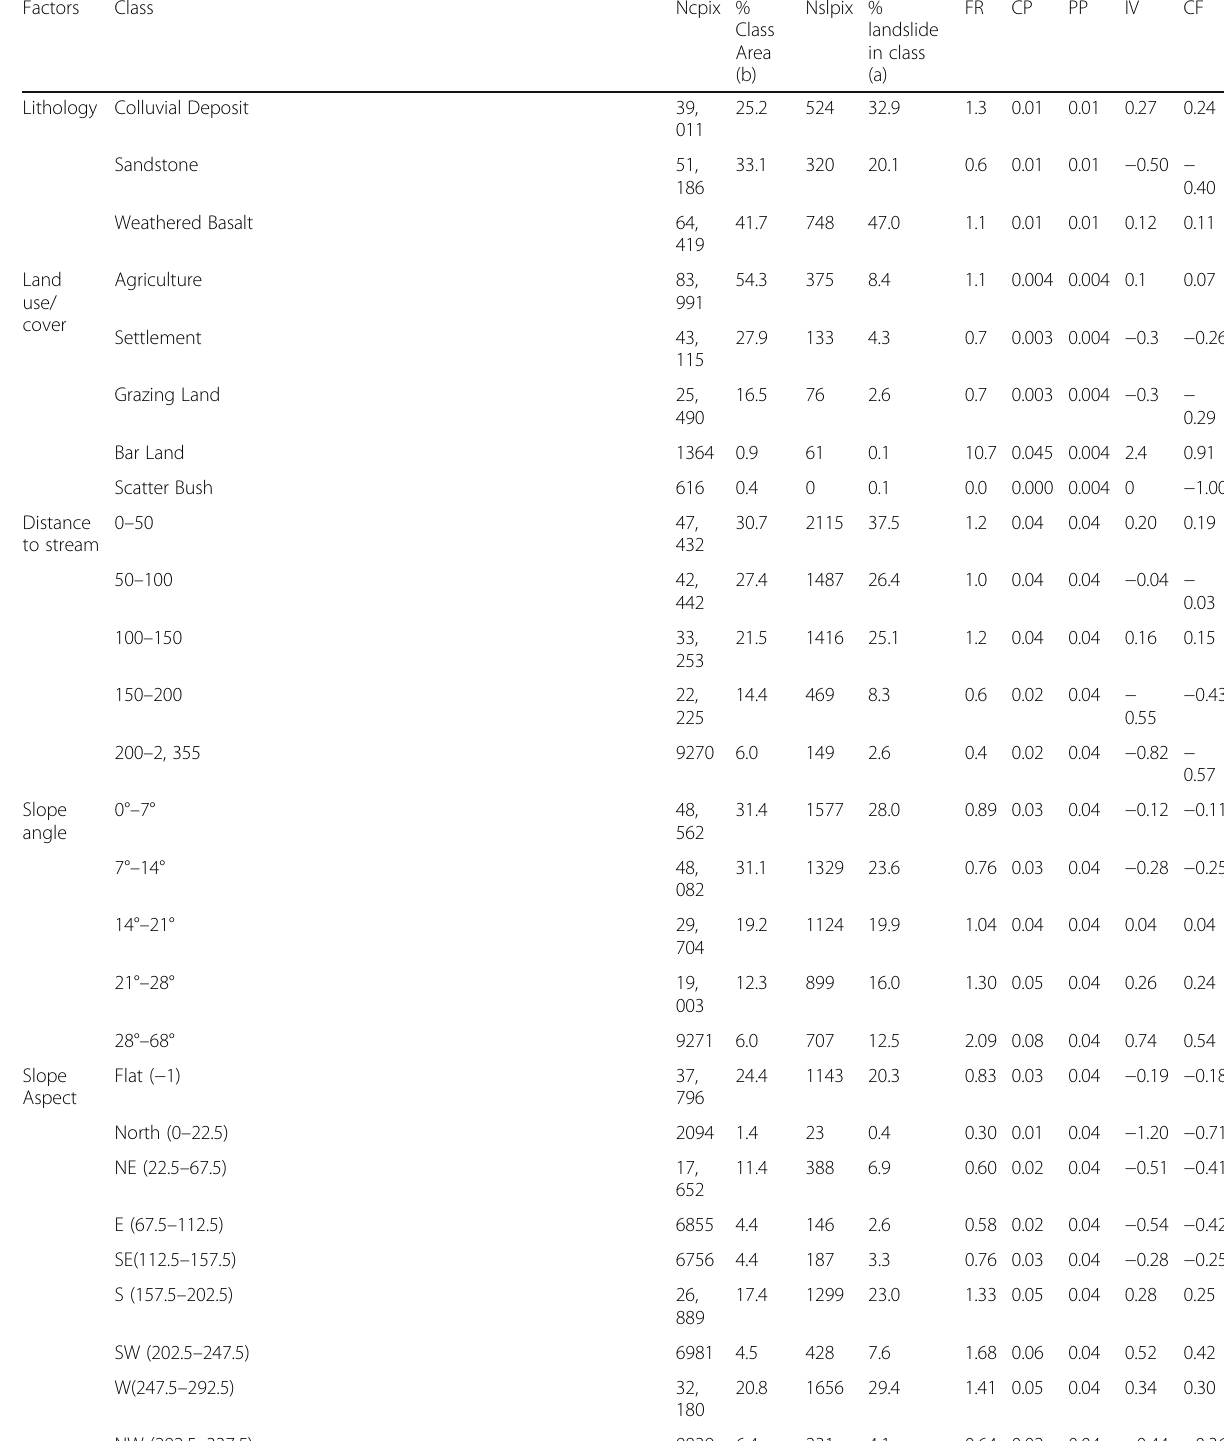
Table 2 Spatial relationship between each landslide factors and landslide using frequency ratio (FR), Certainty factor (CF) and information value (IV)